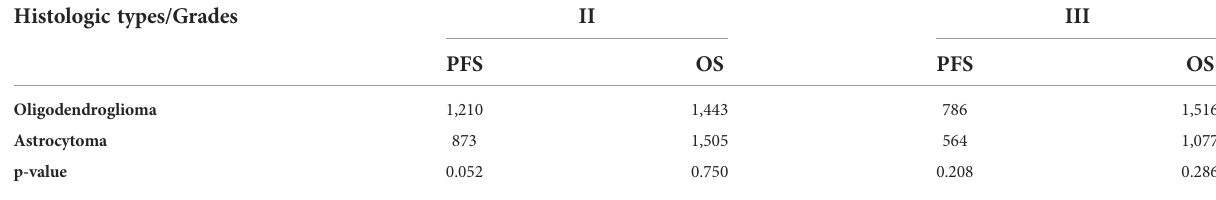
TABLE 2 The survival difference of oligodendroglioma and astrocytoma in LGG.